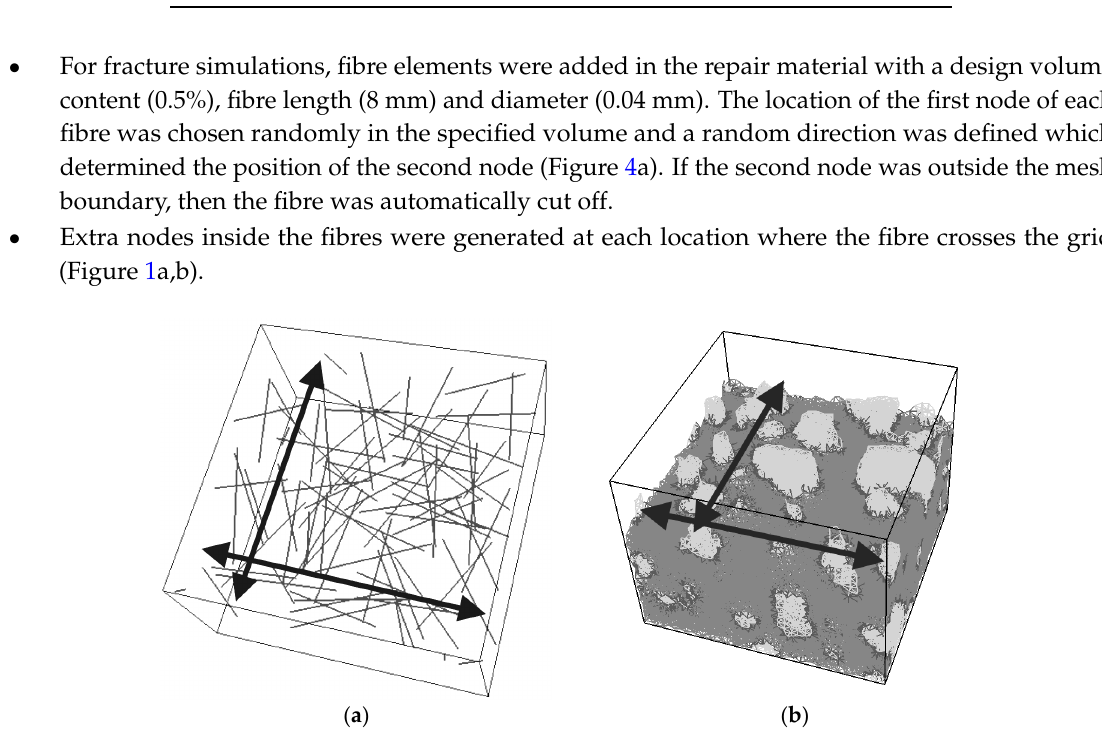
Figure 4. Periodic boundary conditions in horizontal directions for ( a ) fibres ( grey colour) in the SHCC repair material ( b ) aggregates ( light grey colour) in the concrete substrate.